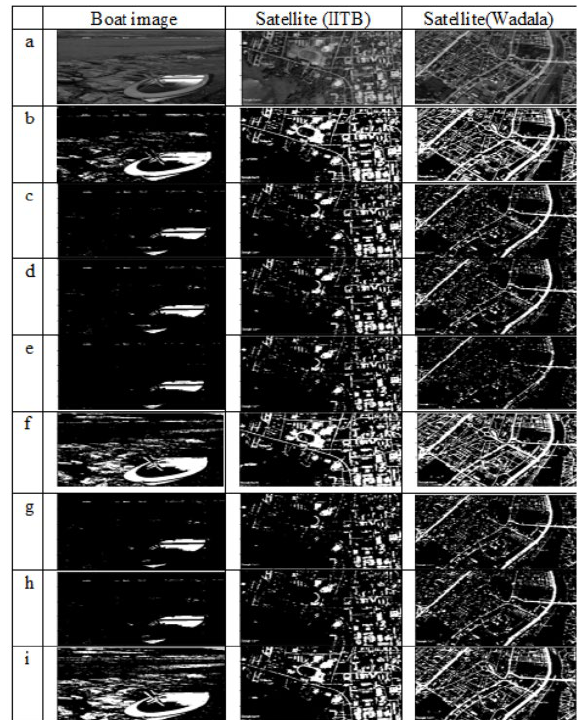
Figure 2 : Segmented images using a) Original b) DE-OTSU